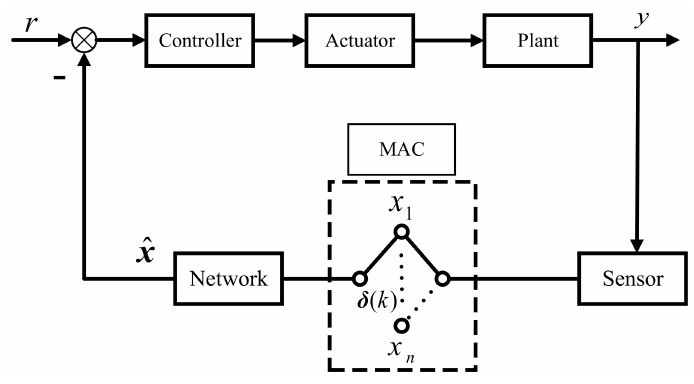
Figure 1. NCS with